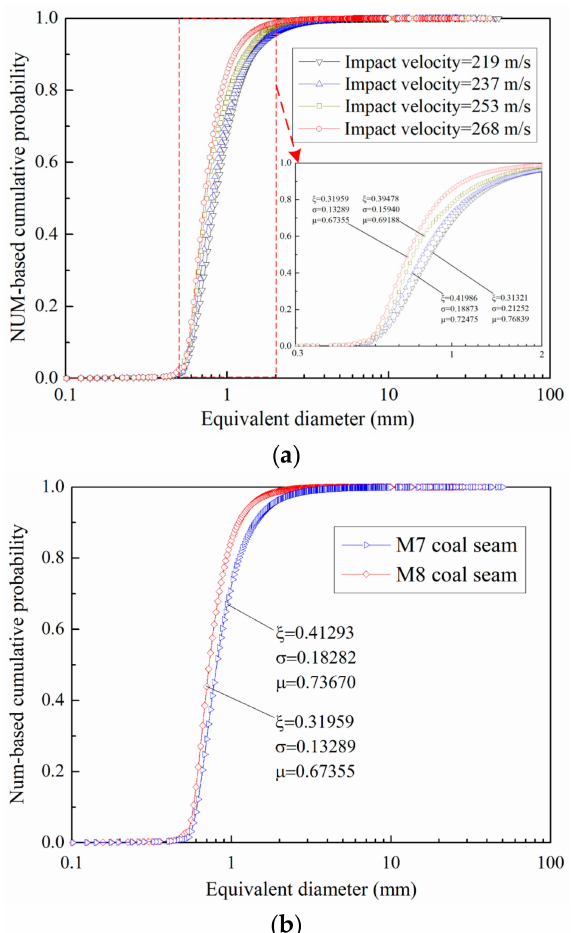
Figure 7. Experimental data of NUM-based cumulative probability for the equivalent diameter of coal fragments and fitted curves. ( a ) Size distributions of coal fragments under different jet impact velocities in the M8 coal seam. ( b ) Fragment size distributions of the various coal seams under a jet velocity of 268 m/s